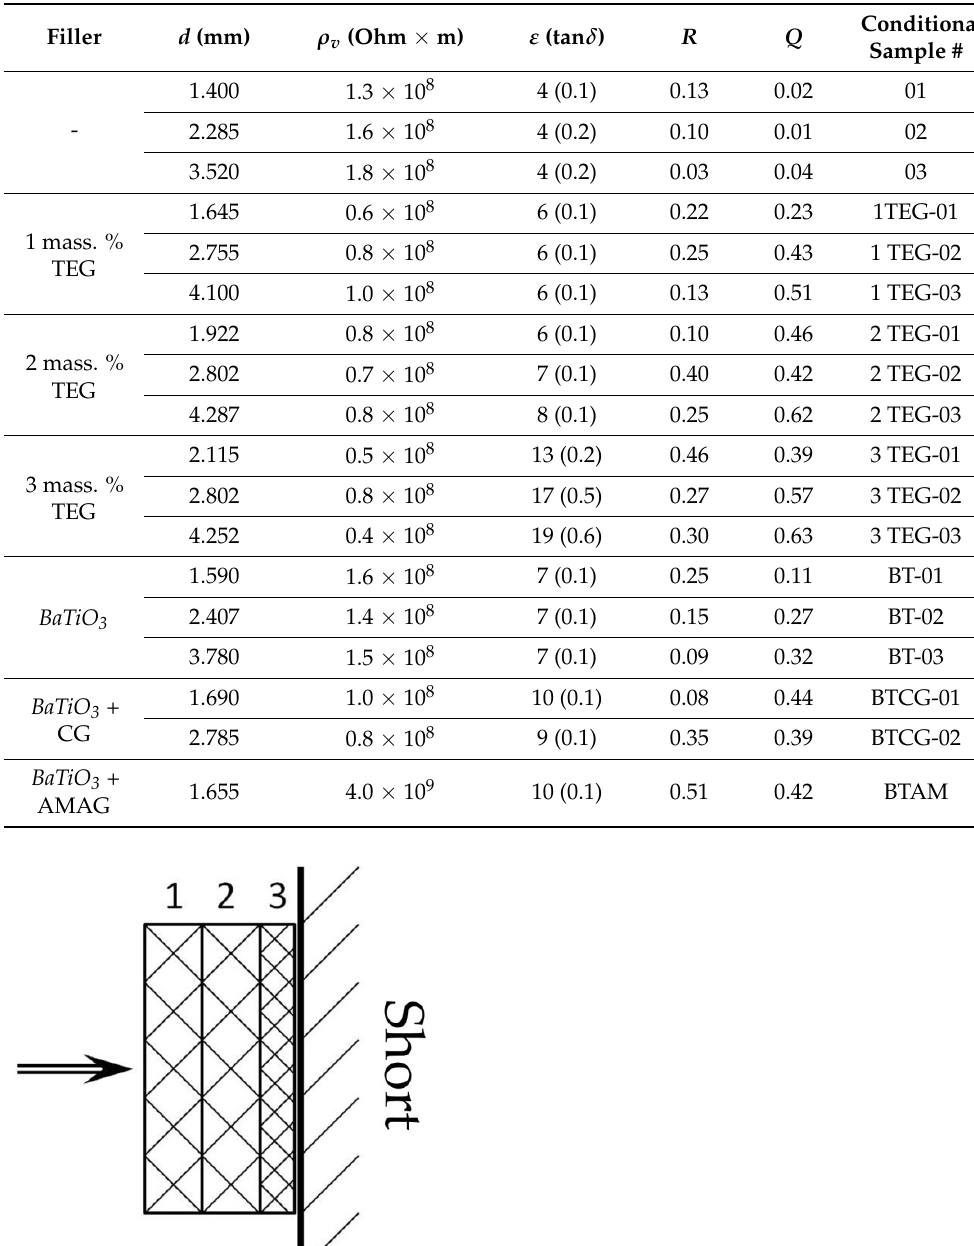
Table 18. Electrophysical properties of composites based on PVC-filled plastics.